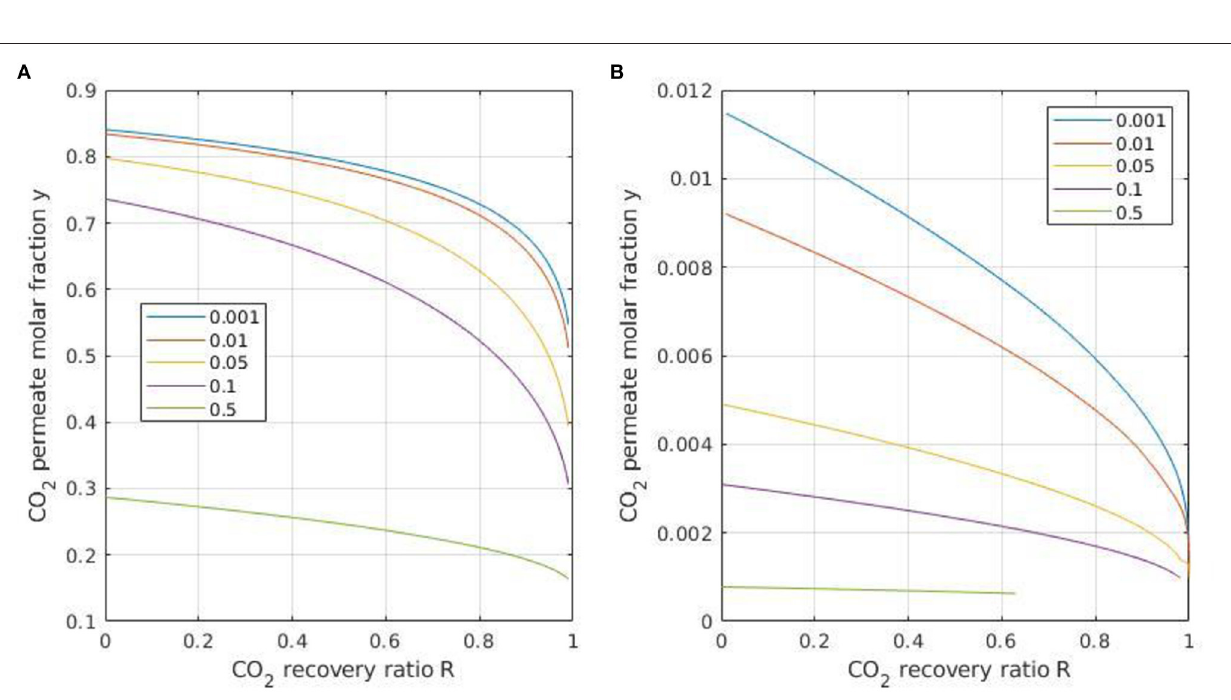
FIGURE 5 | Permeate purity y as a function of recovery ratio R for different pressure ratios (indicated in the rectangle box) for a flue gas feed mixture (x IN = 0.15) (A) and air feed (x IN = 400 ppm) (B) . Polaris membrane performances (#3 in Table 2 ), cross plug flow